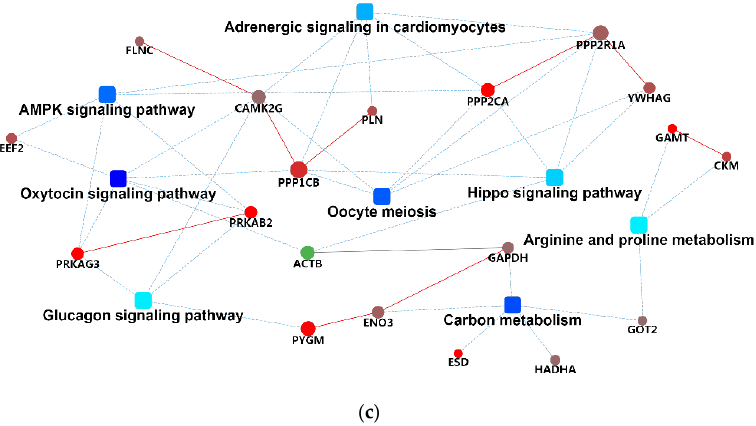
Figure 4. ( a ) GO functional classification; ( b ) significant Kyoto Encyclopedia of Genes and Genomes (KEGG) pathway; ( c ) protein – protein interaction (PPI) network of the differentially expressed proteins between the pale, soft and exudative (PSE), and red, firm and non-exudative (RFN) meat.